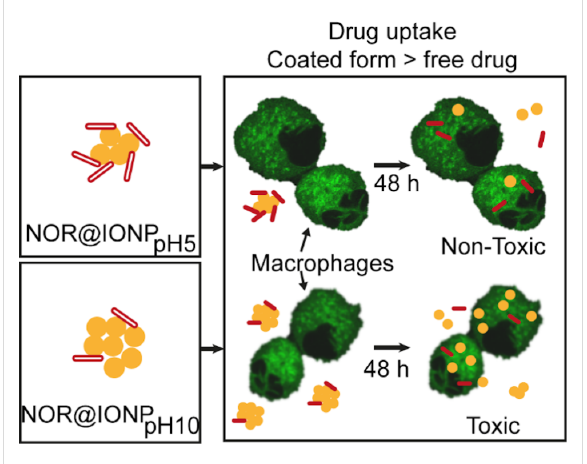
Figure 7: Schematic showing the effect of NOR@IONPs, coated at either pH 5 or at pH 10, on its role in drug and nanoparticle uptake in macrophage cells. Yellow circles represent the IONPs while red rods represent the drug (NOR). The macrophage cells are in green with black regions depicting unstained regions in the